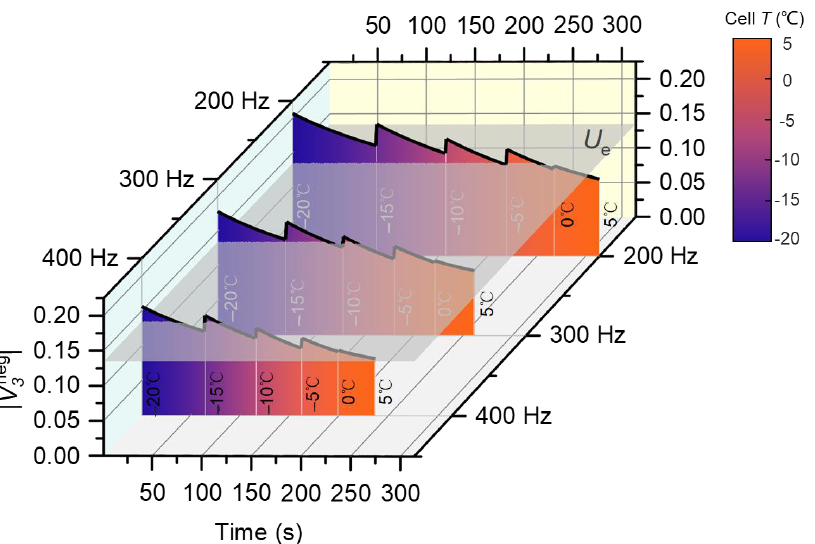
Figure 14. The variation in | V 3 neg | in the preheating process of using the method based on the terminal voltage control. The frequencies are 200, 300 and 400 Hz, the preheating adopts the temperature-adaptive procedure with the temperature interval of 5 ◦ C, and the maximum permissible current amplitudes are presented in Supplementary Figure S4b.